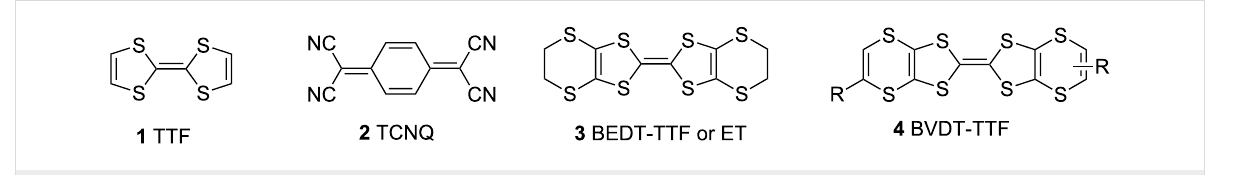
Figure 1: Chemical structure of the TTF analogues and TCNQ.